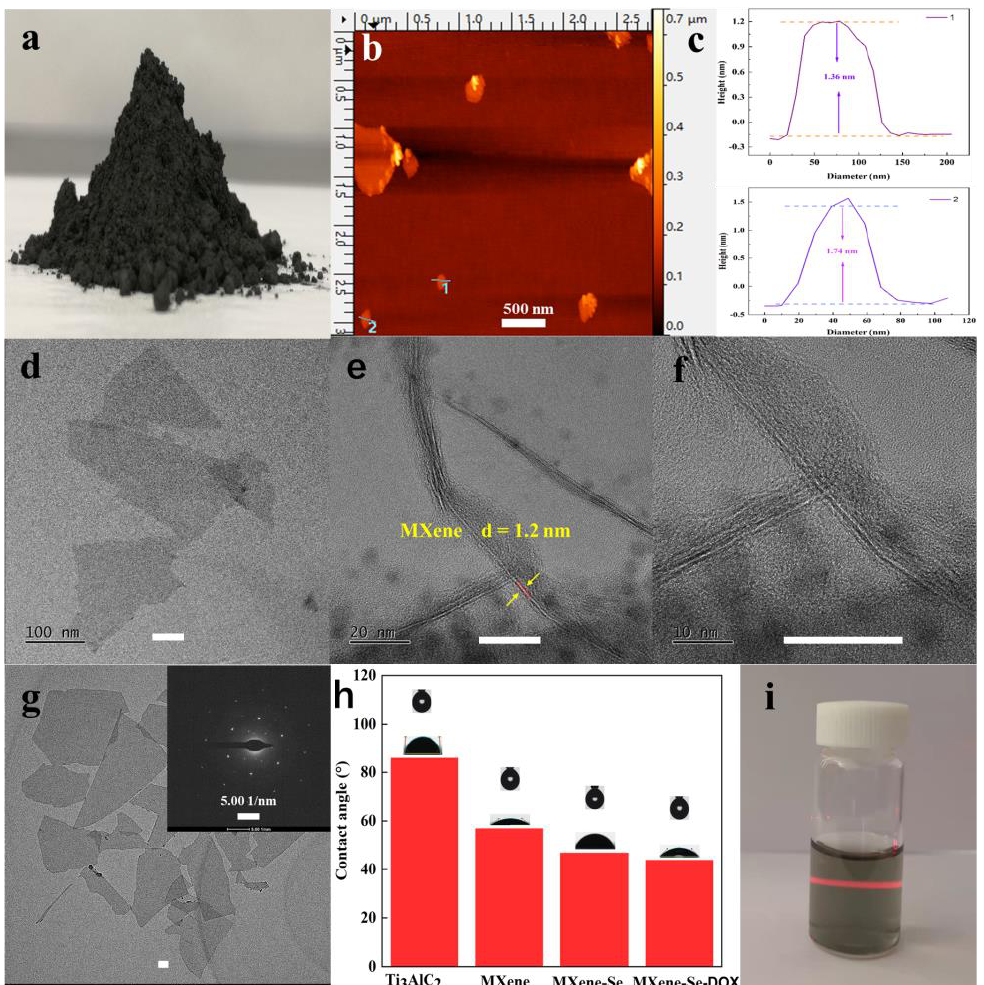
Figure 4. ( a ) Photograph of commercial Ti 3 AlC 2 powder. ( b ) AFM image of MXene nanosheets. ( c ) Thickness and diameter of MXene nanosheets measured using AFM. ( d ) TEM image of ultrathin planar MXene nanosheets after exfoliation. ( e , f ) HR-TEM images of MXene nanosheets. ( g ) MXene flakes and the selected area electron diffraction (SAED) (inset). ( h ) Water contact angles for Ti 3 AlC 2 , MXene, MXene-Se, and MXene-Se-DOX nanosheets. ( i ) Tyndall effect detection in MXene nanosheets. The scale bars (white color) for ( b , d , g ), and ( e , f ) are 500, 50, and 20 nm, respectively, while the scale bar for SAED image (inset in the g image) is 5.00 nm − 1 .